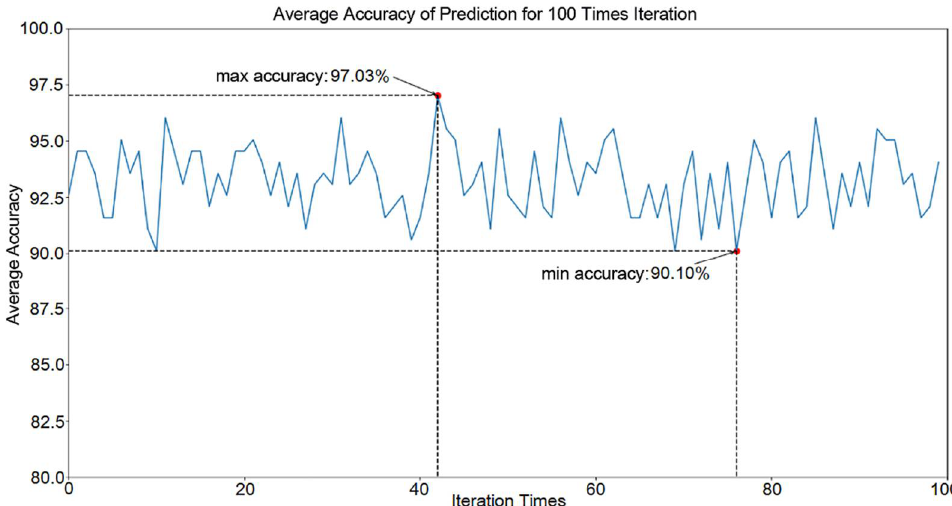
Figure 7. The average results of classification iterated 100 times.